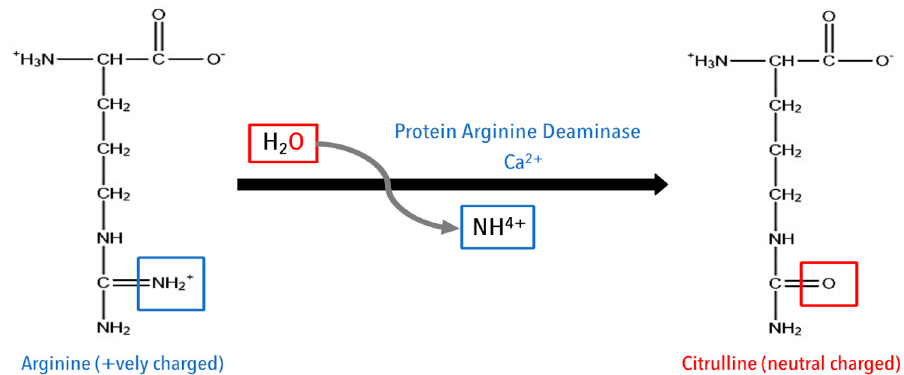
Figure 2. Schematic representation of citrullination.